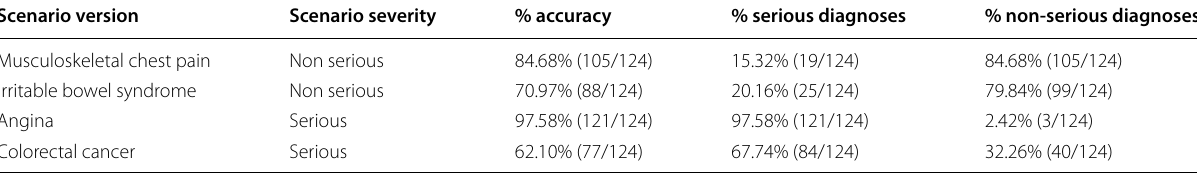
Table 3 Diagnoses by scenario